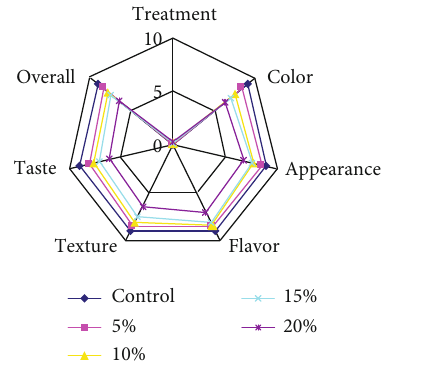
Figure 1: Sensory evaluation of biscuits forti fi ed banana peel fl our.